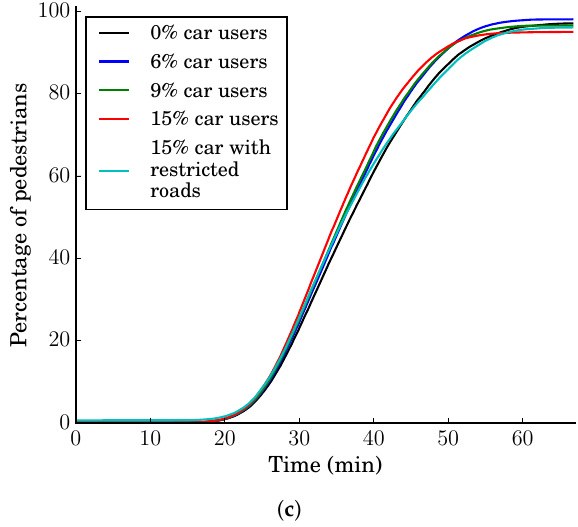
Figure 11. Comparisons of evacuation progress under each of the five scenarios considered: ( a ) Total progress, ( b ) Progress of cars, ( c ) Progress of pedestrians. 0 . 0